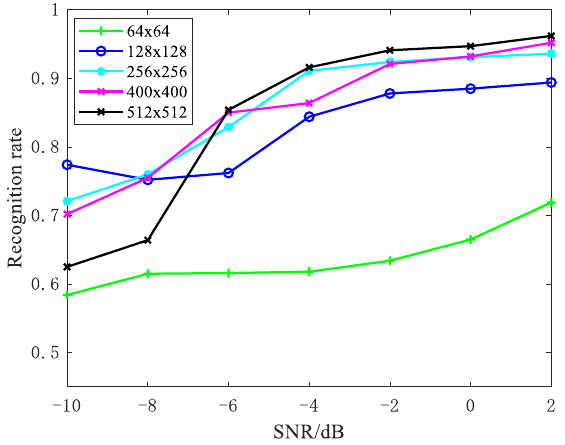
Figure 11. Recognition rate with image sizes.